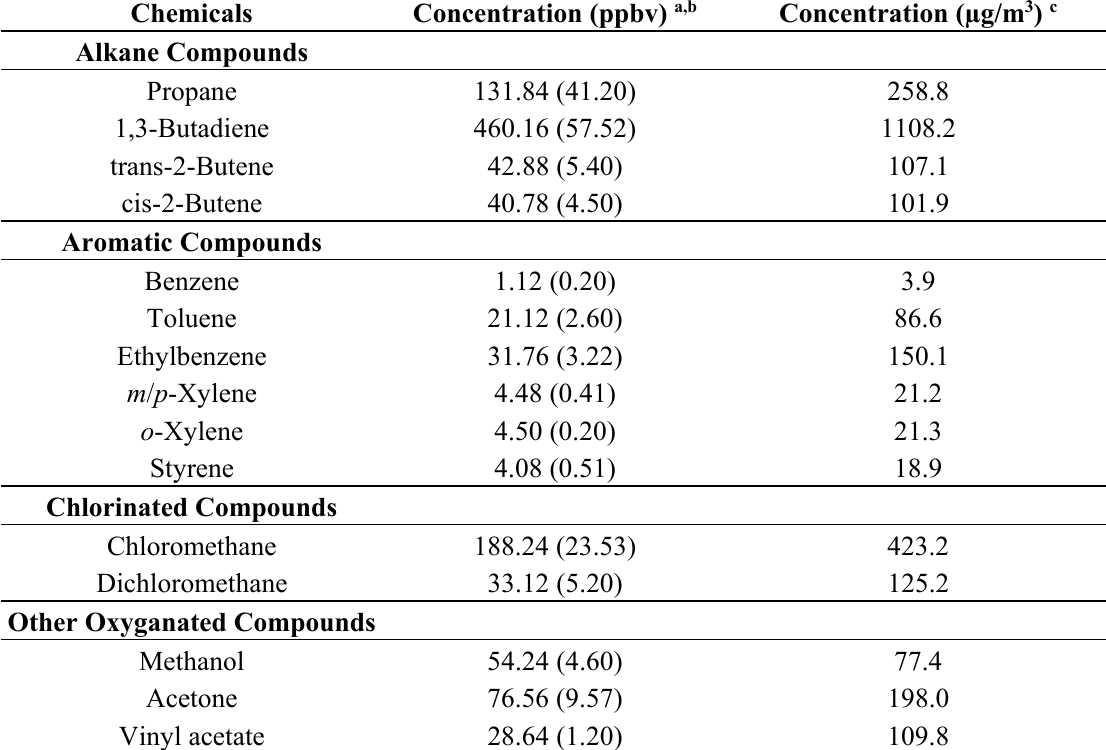
Table 1. Main gaseous by-products of burning incense